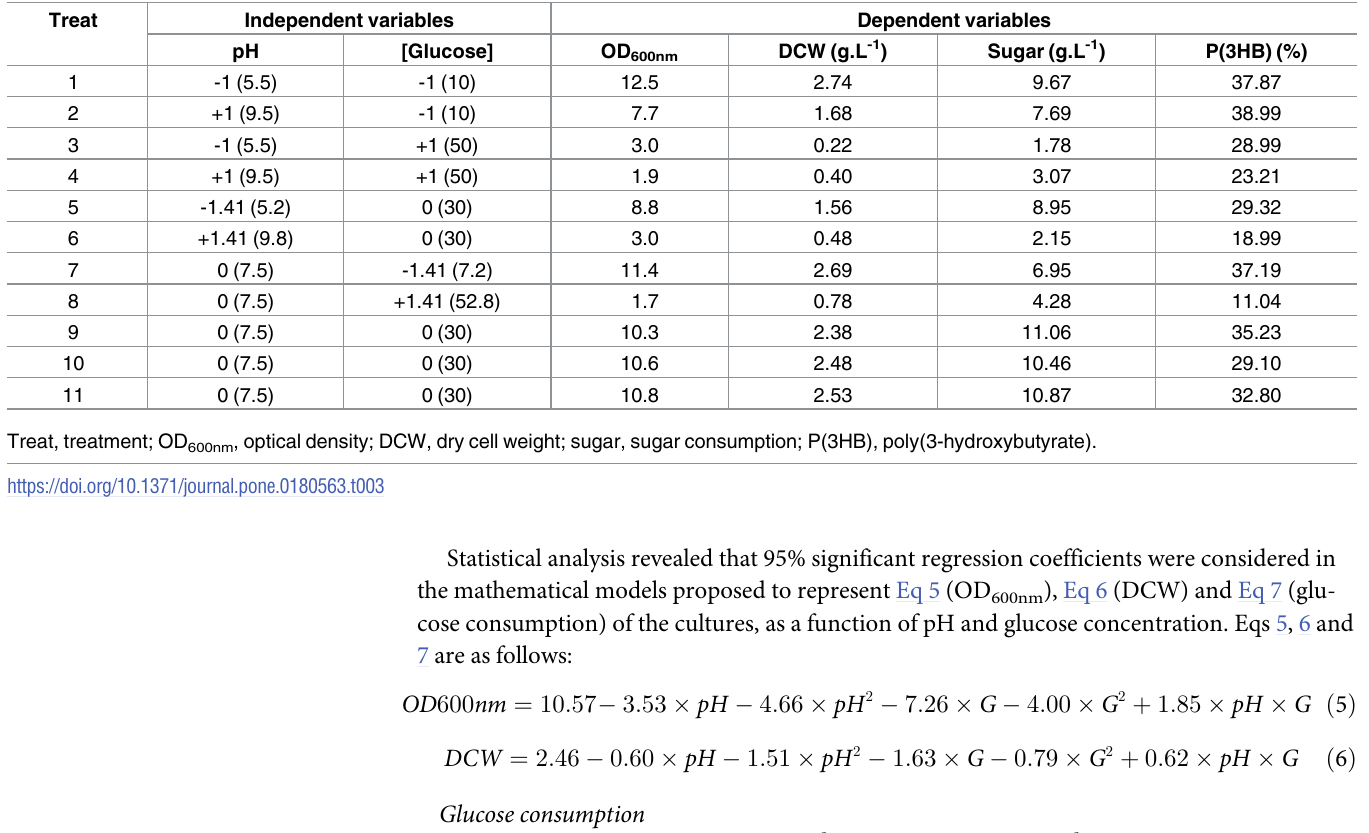
Table 3. Matrix of the experimental planning CCRD 2 2 . Coded and real levels as well as values of the responsevariablesobtainedfor R . solanacearum RS inoculumincubatedat 32˚C and 250 rpm for 24 h and YM culture medium with glucose.